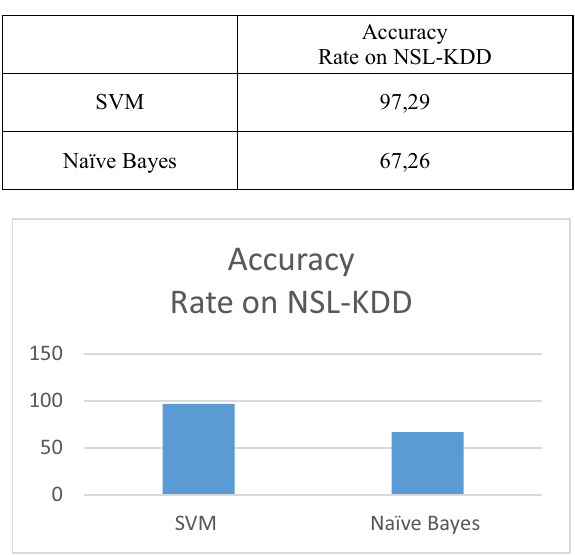
Table 4. Accuracy rate of attacks (NSL-KDD).